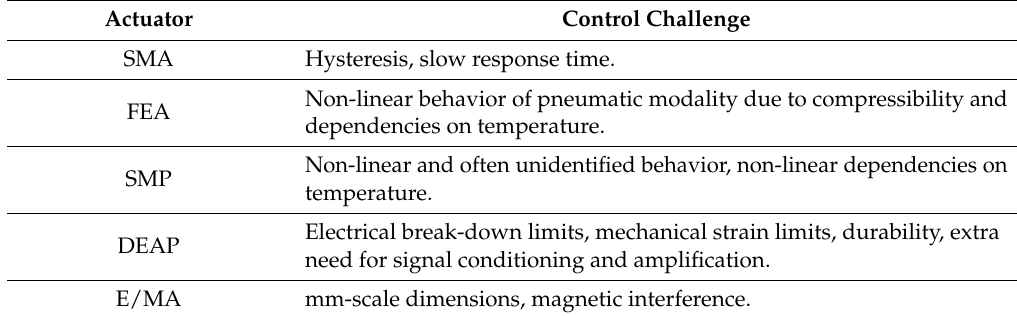
Table 4. Evaluation of soft/novel actuators according to operation range (Section